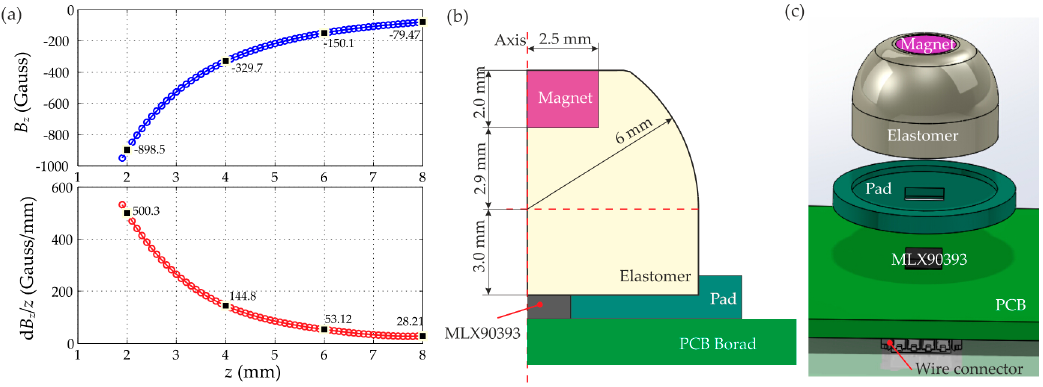
Figure 8. ( a ) Magnetic field Bz and its gradient along the z axis; ( b ) A cross-section of the MagOne sensor with dimensions; ( c ) Design of the MagOne